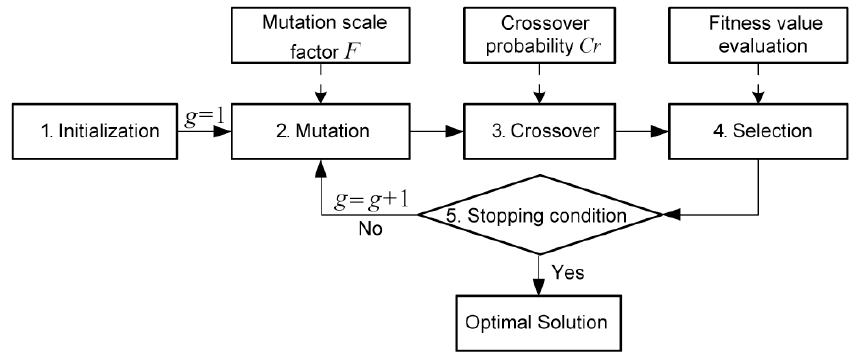
Fig. 3. Differential Evolution optimization